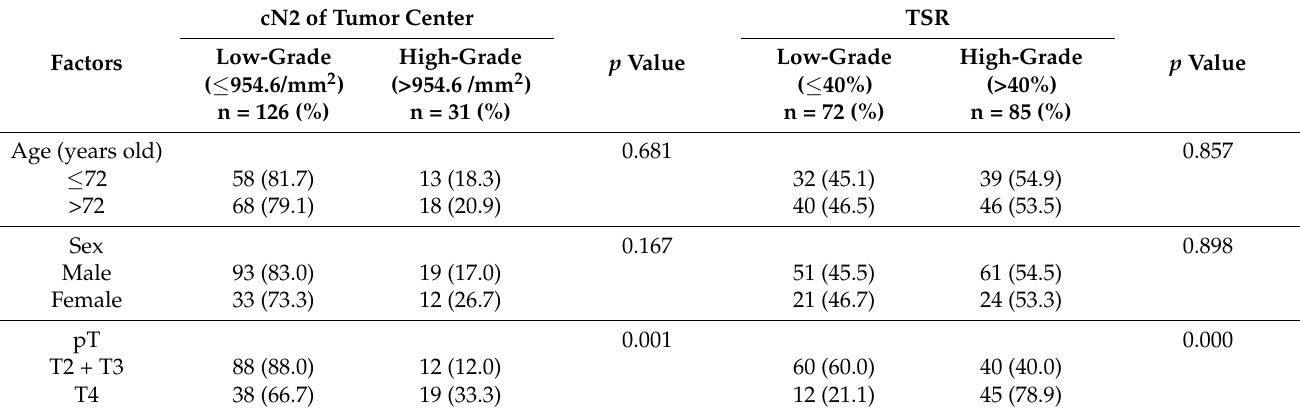
Table 2. Clinicopathological characteristics according to the calculated tumor-associated neutrophils for pro-tumor function and tumor—stromal